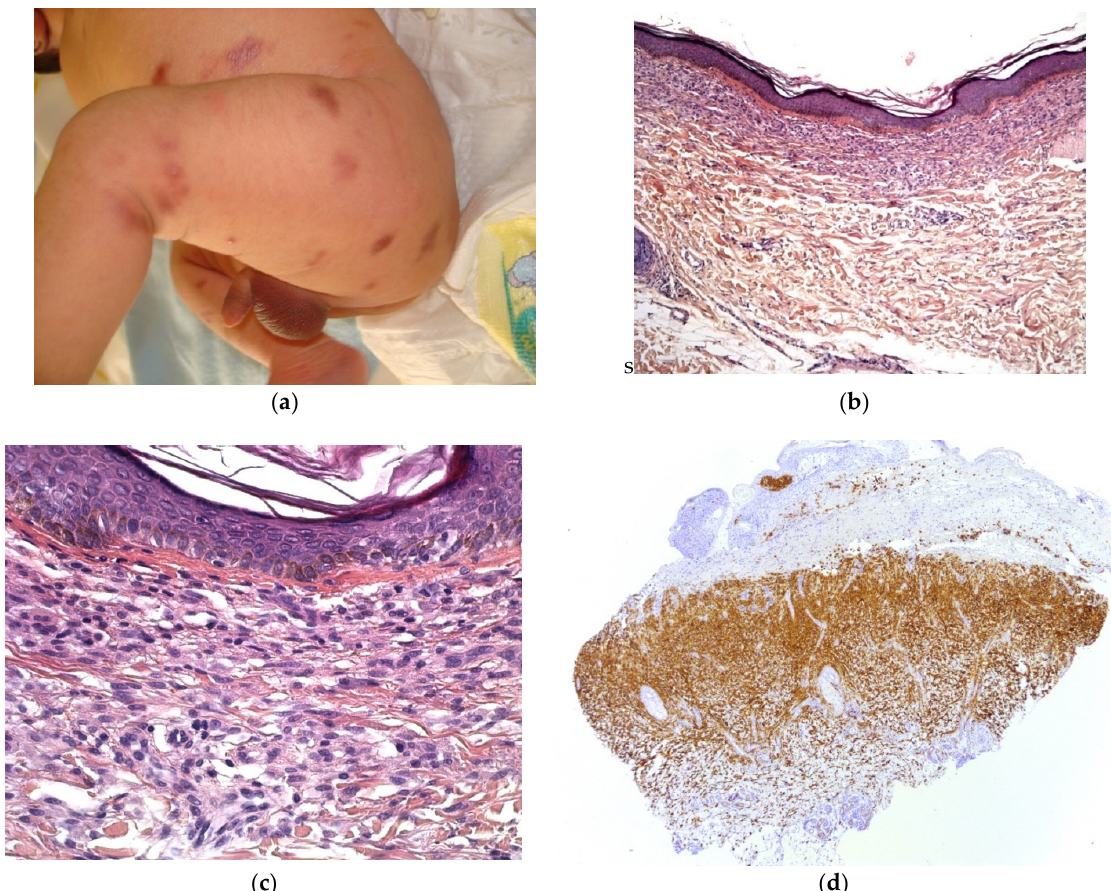
Figure 18. Cutaneous mastocytosis. ( a ) Multiple maculopapular lesions present at birth. ( b ) Rather dense band-like infiltrations at the upper dermis. ( c ) 40× large mast cells containing granules in their cytoplasm. ( d ) anti-CD117 stains mast cells in bullous mastocytosis.